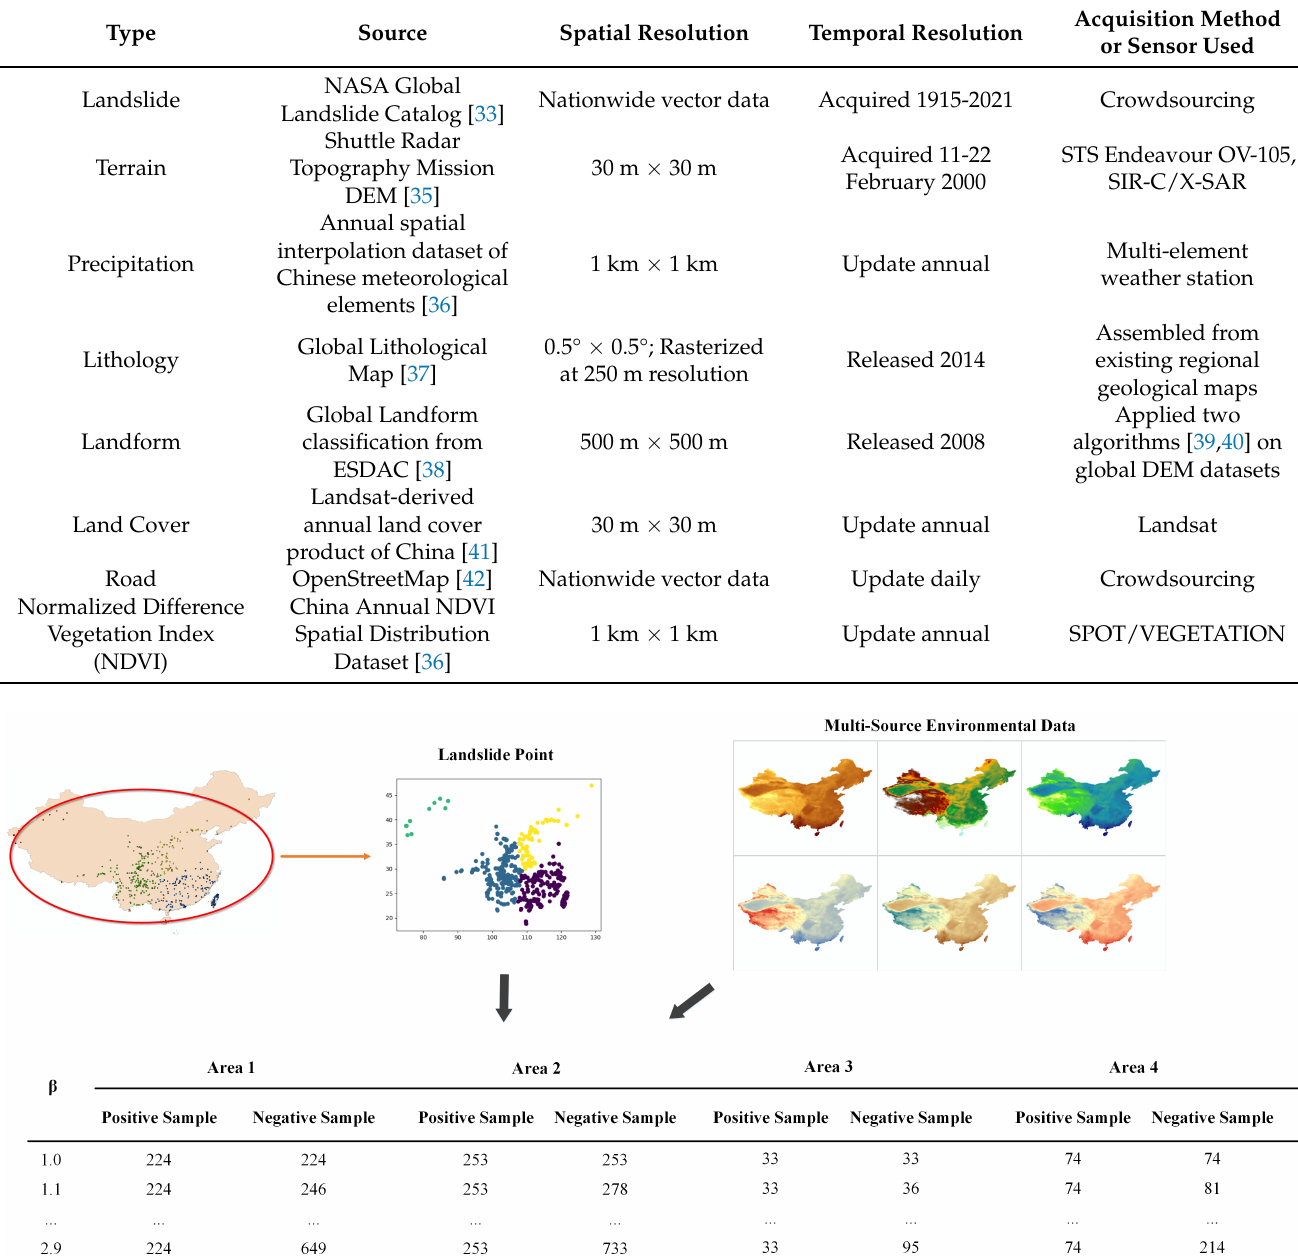
Table 1. Sources and details of experimental data.